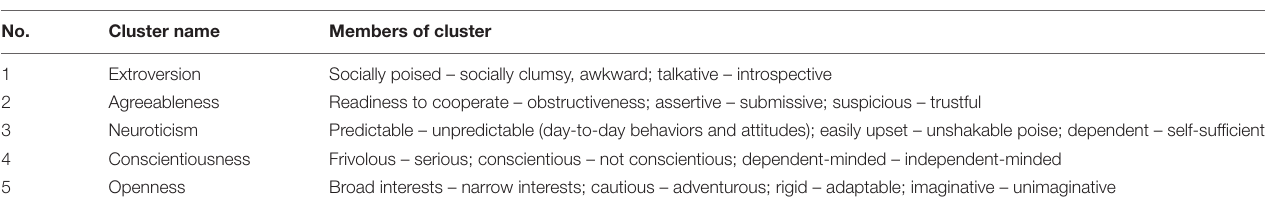
FIGURE 3 | For the first participants of each chain, five non-repetitive words were randomly chosen and combined with a randomly chosen facial image in one trial, each face appearing only once. In the probe phase, 36 words were listed in a 9 × 4 matrix for participants to choose from. In the probe phase of each trial, the presentation of the 36 words would be randomized. For subsequent participants, the combination of facial images and five impression words reproduced by the previous participants would be presented as the items to memorize. TABLE 1 | Five clusters of personality trait